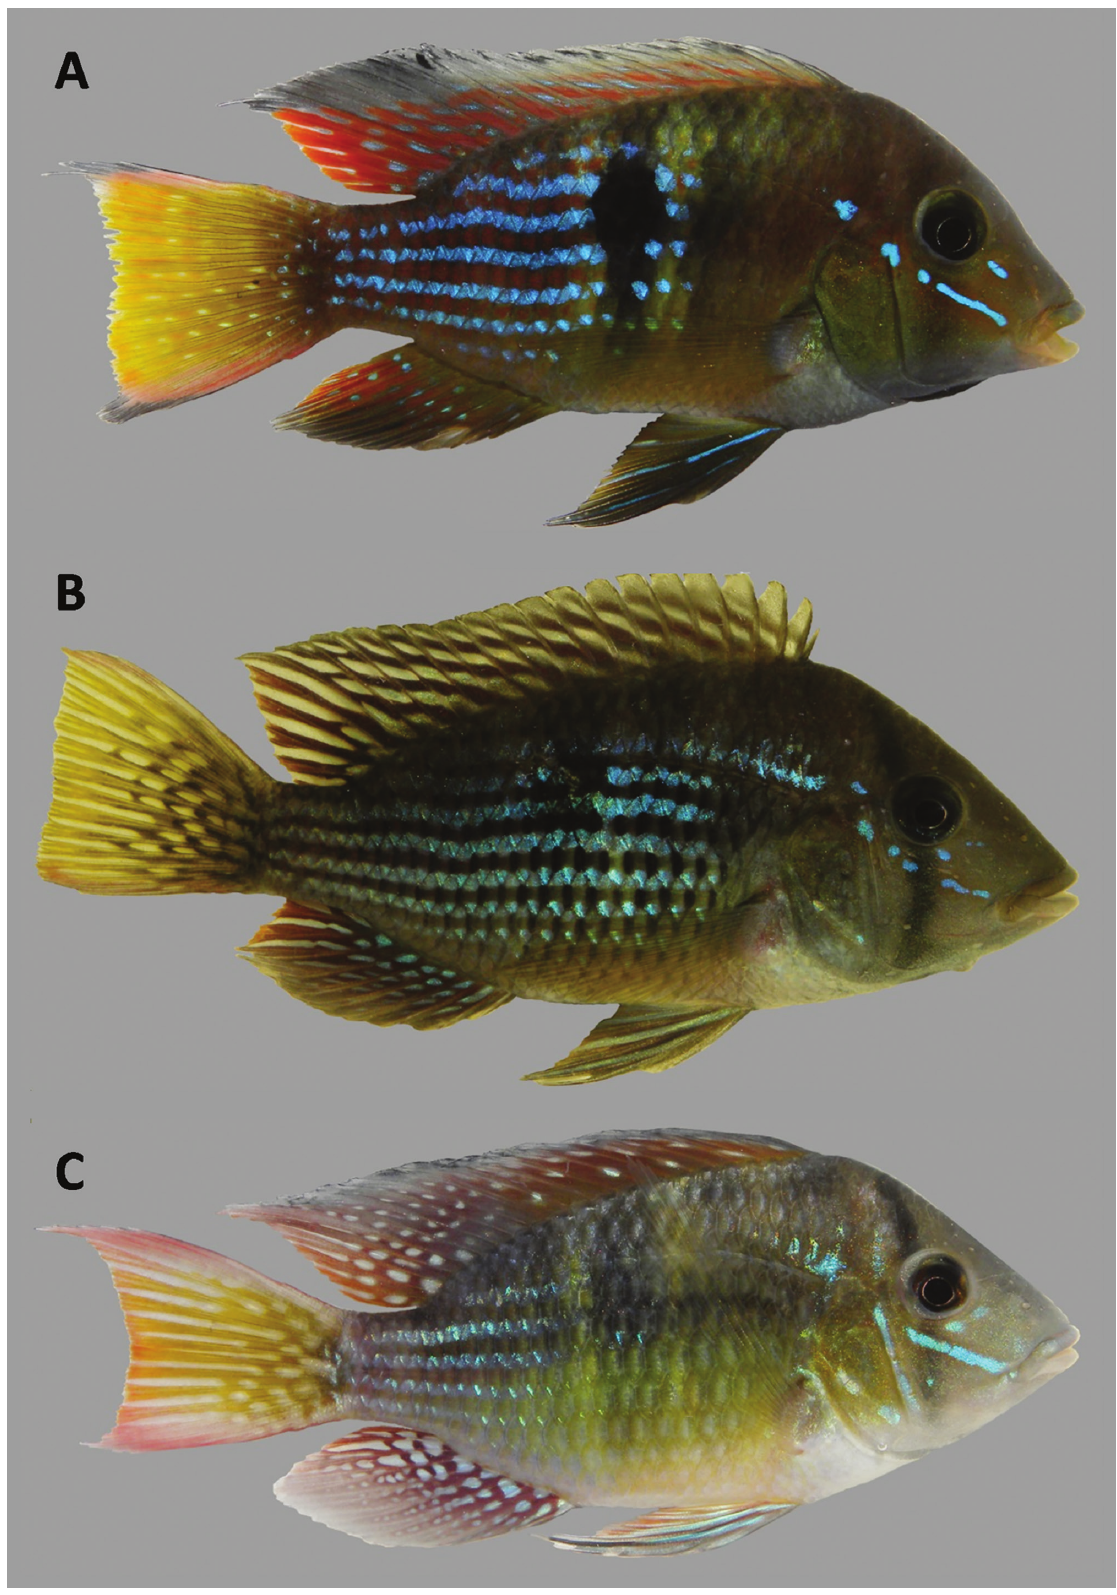
Fig. 2 . Non-type live specimens of (A) Gymnogeophagus terrapurpura from rio Santa Lucía basin, Canelones Department, Uruguay, (B) G. rhabdotus and (C) G. meridionalis. (B) and (C) both from rio Negro basin, Tacuarembó Department,